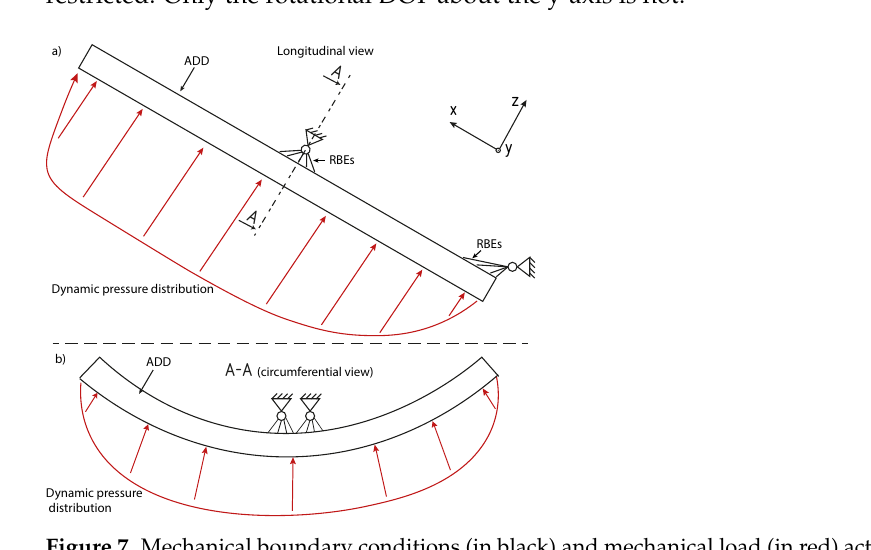
Figure 7. Mechanical boundary conditions (in black) and mechanical load (in red) acting on the ADD: ( a ) in a longitudinal view of the ADD, ( b ) in a circumferential cut (A–A)